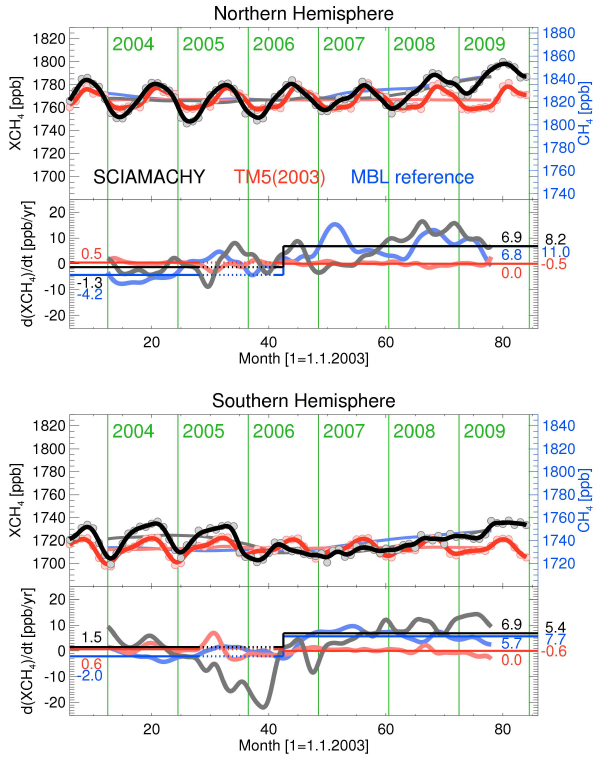
Fig. 14. As Fig. 3 but for WFMDv2.0.2 XCH 4 . The anomaly (num- bers on the right border) is defined as the difference of the mean values of the derivative of the deseasonalised trend after and before middle of 2006. Values one year around the detector pixel mask al- teration end of October 2005 (indicated by the dotted lines) are not considered because systematic offsets due to the change are poten- tially distorting the deseasonalised trend (obtained by smoothing) and its derivative. As the TM5 model is only available for 2003, the corresponding values are repeated every year to study the am- plitudes of the seasonal cycles and the impact of sampling on the observed anomaly because it is expected to be zero for the repeated model if there is no sampling influence. Hence, the anomaly of the model is a lower bound of the error of the observed SCIAMACHY anomaly. To assess the expected absolute values and temporal evo- lution of the increase at least approximately, the SCIAMACHY data are also compared to the deseasonalised trend of the Marine Boundary Layer reference matrix derived using NOAA/ESRL sur- face measurements averaged over the respective hemisphere (blue). The MBL reference data through 2009 are